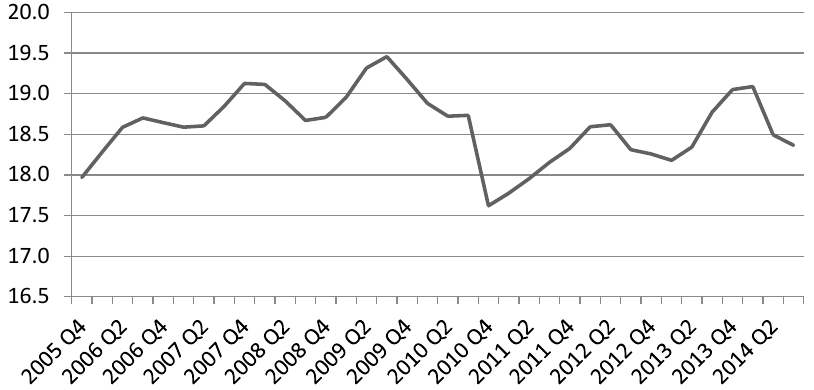
Figure 2. Olympic sport rates, 1 × 30 definition, seasonally adjusted participation.